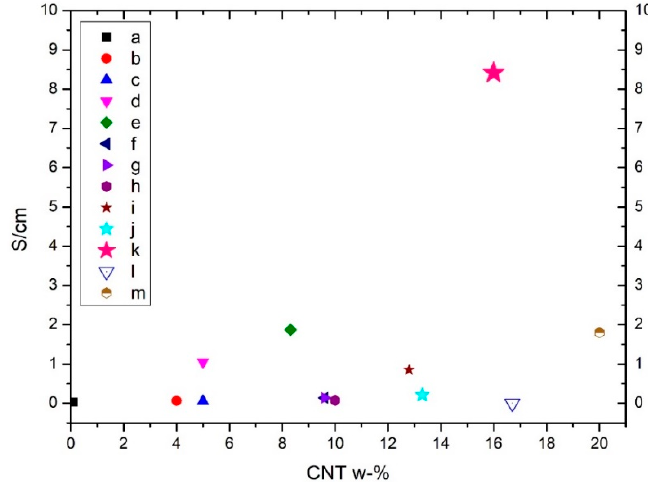
Figure 3. Comparison of obtained electrical conductivity of NFC-CNT nanocomposite films from the current literature. Pink star (letter k) refers to our data (Triton X-100), while other letters refer to a